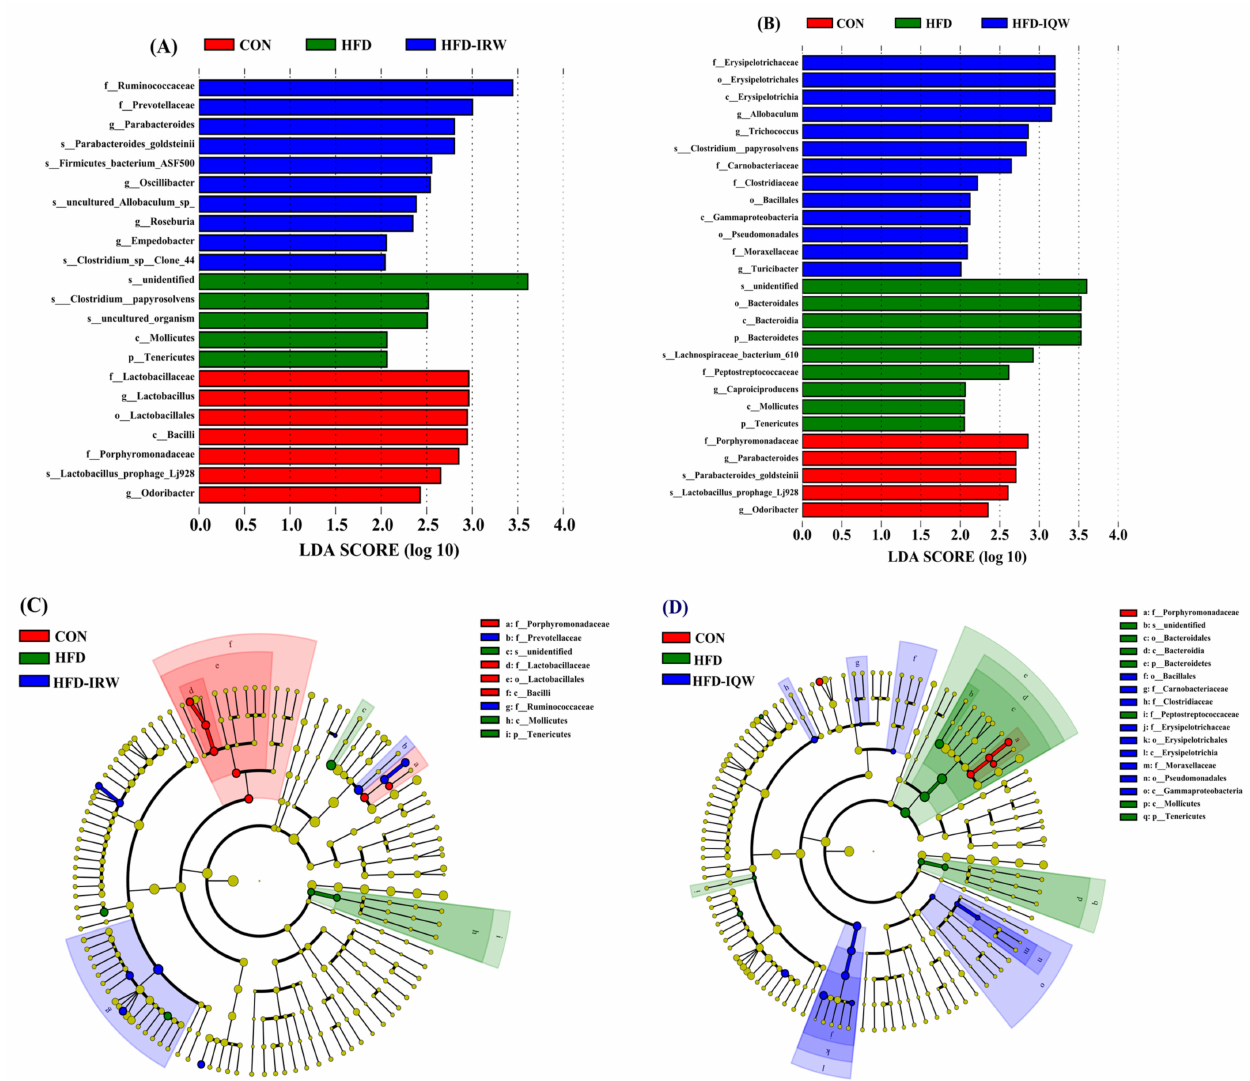
Figure 6. LEfSe analysis of microbiota in colon content. Linear discriminant analysis among ( A ) and ( C ) CON, HFD, and HFD-IRW, ( B ) and ( D ) among CON, HFD, and HFD-IQW. The red, green, and blue nodes in the phylogenetic tree signify the microbial species which perform a vital role in the groups. The yellow nodes signify the species with no significant